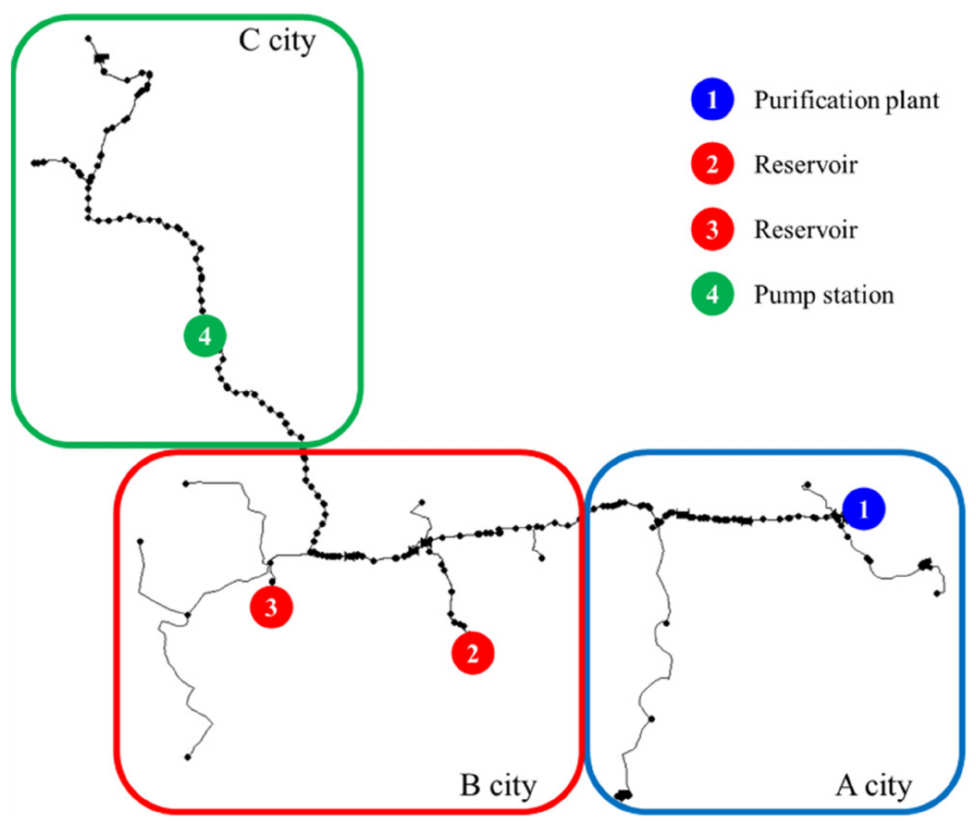
Figure 3. Study network and location of smart